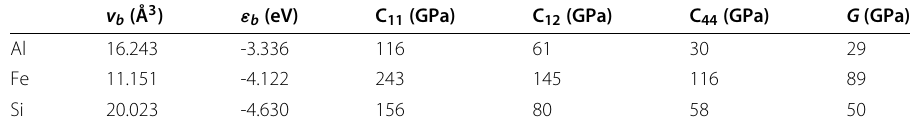
Table 1 Bulk atomic volume v b and cohesive energy ε b , elastic constants and shear modulus G = ( C 11 − C 12 + 3C 44 )/ 5 for the three materials/potentials used in the